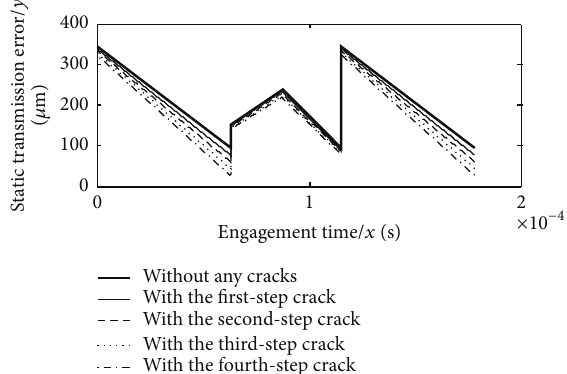
Figure 10: The simulation of the STE of the example case.